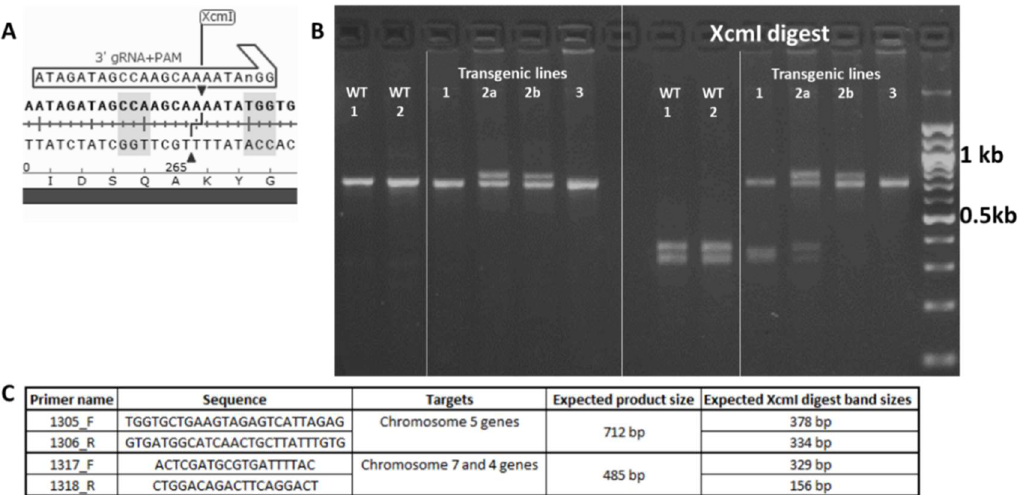
Figure 2. Screen to identify targeted Sal1 mutations. ( A ) Location of the Xcm I cut site within the 3′ gDNA targeted region (the shaded CCA………TGG nucleotides denote the recognition site). ( B ) Agarose gel electrophoresis showing the PCR product of the chromosome 5 screening primers in wildtype Bobwhite (WT) and mutant transgenic lines before and after XcmI digest. Wildtype PCR product is completely cut by XcmI, whereas those with mutations in the 3′ site show larger and/or uncut bands. Transgenic lines 2a and 2b are sibling lines that inherited the same 56 bp DNA insertion into the 3′ site of 5D, which appears here as a larger band in the PCR assay. ( C ) Primers used in PCR amplification of the 3′ target regions screened in the assay.